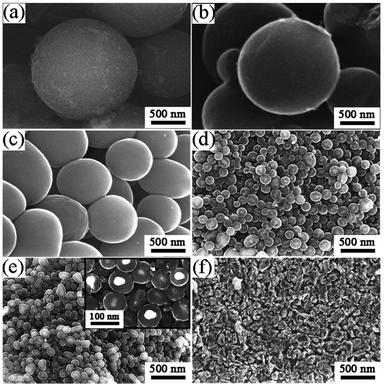
FESEM images of (a) D@C-0, (b) D@C-0.25, (c) D@C-0.5, (d) D@C-0.75, (e) D@C-1.0, Magnified SEM image of D@C-1.0 in the inset (f) D@C-1.25 composite particles.